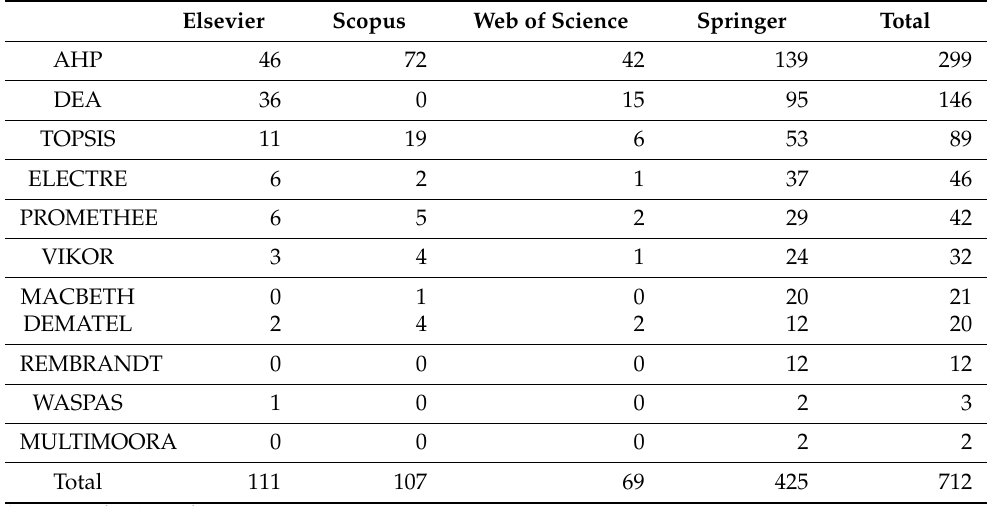
Table A2. The publications with different MCDM techniques in the field urban transport.